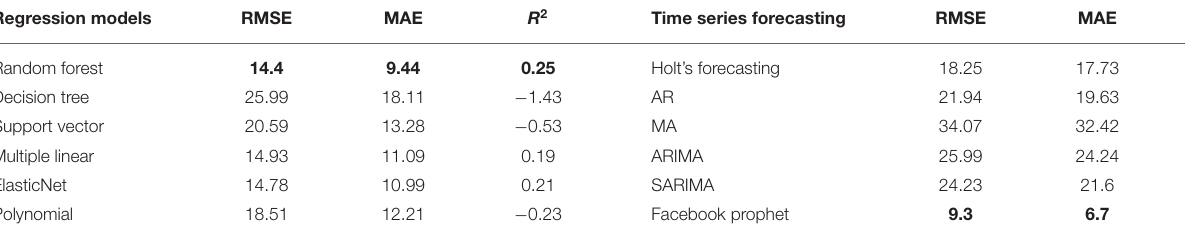
TABLE 8 | Performance metrics comparison table for Pune. Regression models